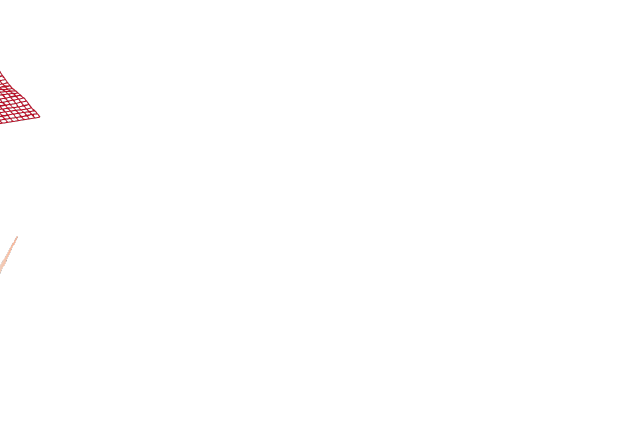
Figure 8. Loss landscape where the bottom surface indicates the manifold for the classifier while the surface on the top indicates the manifold for the auto-encoder attached to the